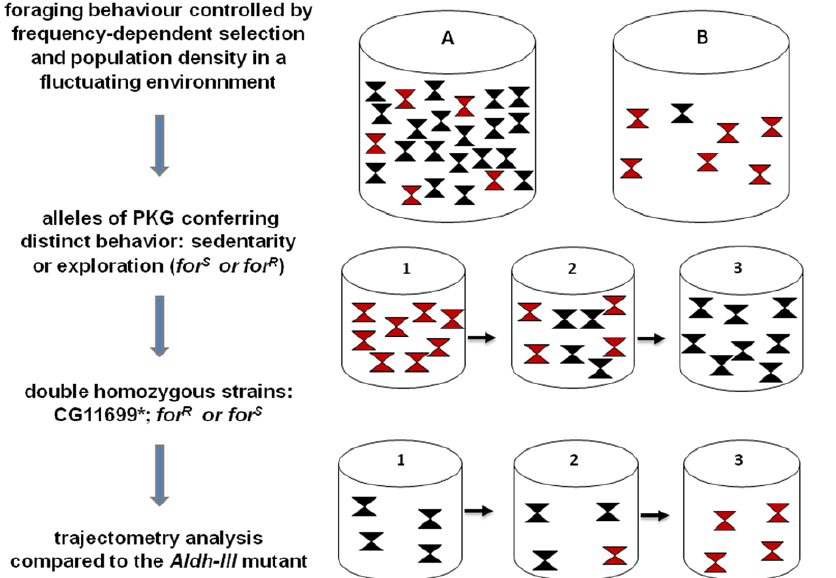
Figure 1. Experimental scheme used in this study and illustration of density-dependent selection of genes in relation to phenotype transmission. ( left ) Experimental design used to demonstrate the pleiotropic effects of the frequency- and density-dependent gene for . Double- hybrid system analysis has previously shown a strong probability of interaction (0.7) between CG11699 and Aldh-III and a lower probability (0.4) of association between CG11699 and PKG, the product of the gene for [15]. The genetic backgrounds (expressing specific sets of transcripts of for ) conferring the bimodal behaviors Rover (exploratory) or Sitter (sedentary) were crossed with two CG11699 mutants (containing P-element insertions) using chromosome balancers to construct the double homozygous strains CG11699 *; for R and CG11699* ; for S (see Table S1). These strains were then tested by trajectometry analysis using an arena connected to attractive odorants such as aldehyde compounds and compared with Aldh-III mutants. ( right ) A and B represent high- and low-density populations. Red and black triangles represent phenotypes determined by their corresponding expressed alleles (Rover, for R , black and Sitter, for S , red), dominant in each density context. The second line illustrates the flies from a low-density context raised at high density. The third line illustrates the opposite trend: flies from high-density context are raised at low-density. The progressive change of phenotypes is observed through few generations.